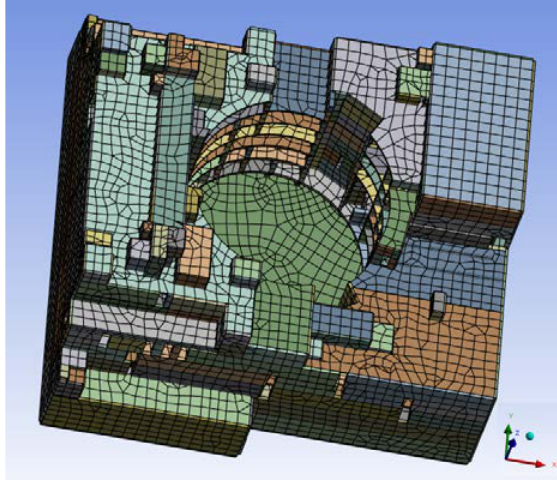
Figure 3. Finite element model of an auxiliary building.